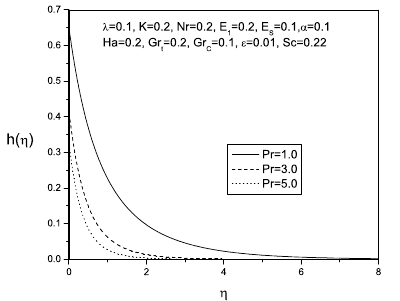
Figure 7. Plot of temperature profiles with η for different values of Nr .